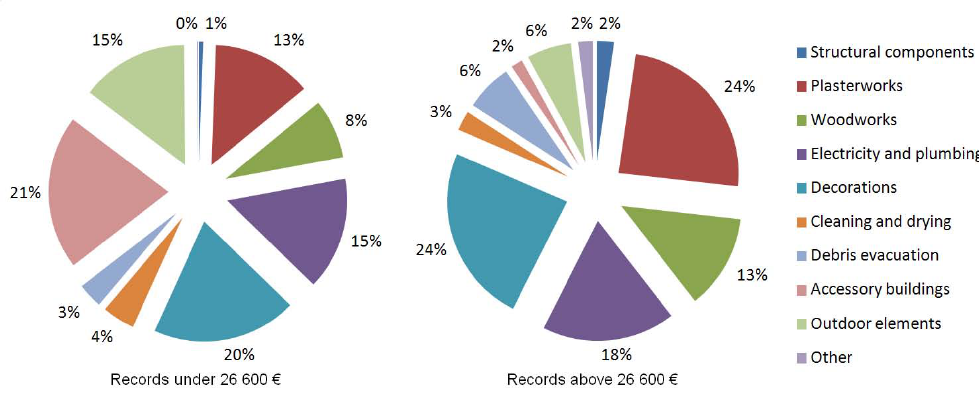
Fig. 4. Pie charts of Xynthia damage costs percentages on residential buildings, broken down according to construction elements. Records split into two groups on both sides of the mean value of 26600 C for housing costs.